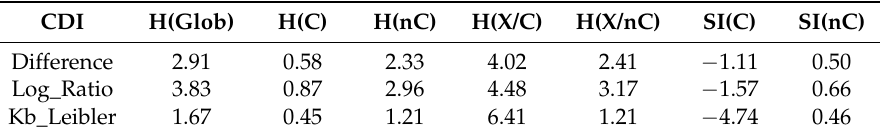
Table 2. DS2, CDI Information (metric) Values.